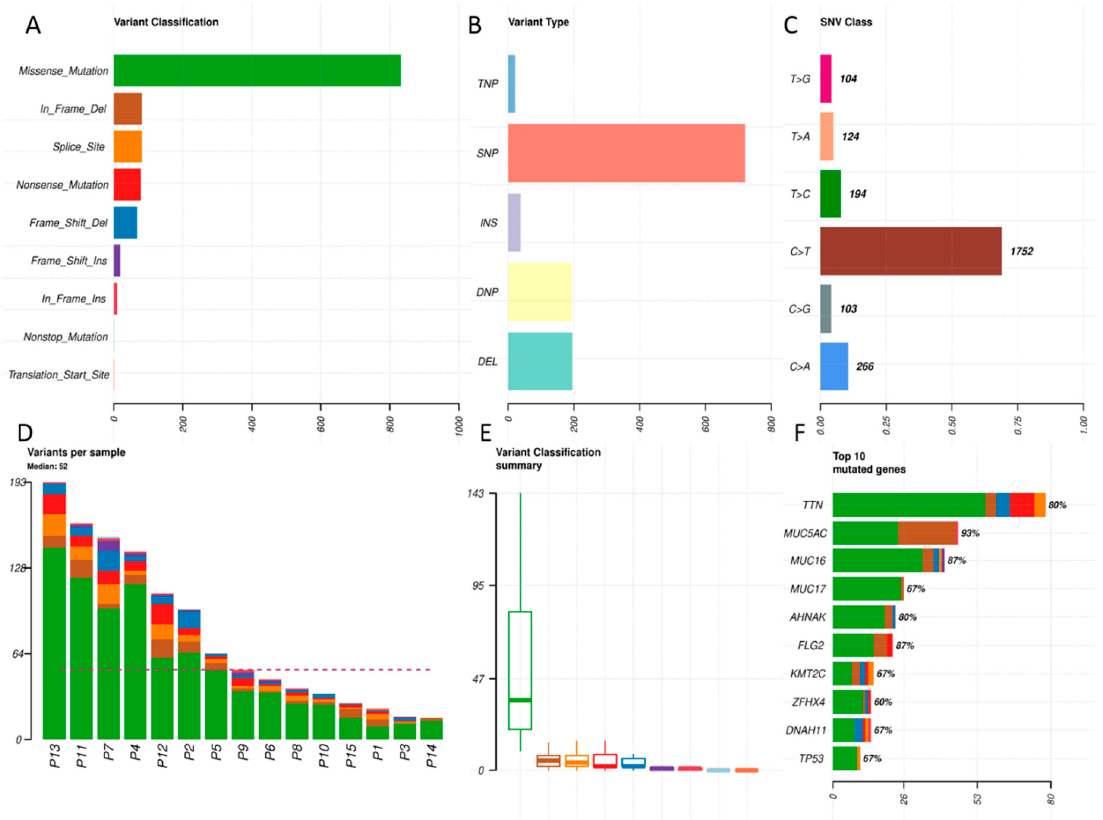
Figure 1. The summary of the distribution of variants in primary tumors. This figure shows the overall distribution of the variants. Only protein-changing variants were considered and 3412 synonymous variants were excluded from the analysis. ( A ) The classification of variants according to the functional effect with counts on the x -axis. Most of the variants found were missense mutations. ( B ) The types of the variants. (TNP stands for trinucleotide variant; SNP, single nucleotide polymorphism; INS, insertion; DNP, dinucleotide variant; DEL, deletion.) ( C ) The type of nucleotide change. Note that the most abundant is C > T transition typical for the formalin-fixed paraffin-embedded (FFPE) origin of the samples. A caution in the interpreting of the data due to the paraffinization artefacts is needed. ( D ) The counts and distribution of the variants for the indicated samples; dashed line represents a median (52 variants per sample). Color coding corresponds to the classification of variants in top left. ( E ) The box and whisker plots of the variant classes recognized by the color coding. ( F ) Top 10 genes with the highest counts of the variants on the x -axis). Percentages of patients harboring any variant in the indicated genes are shown at the top of the bars.